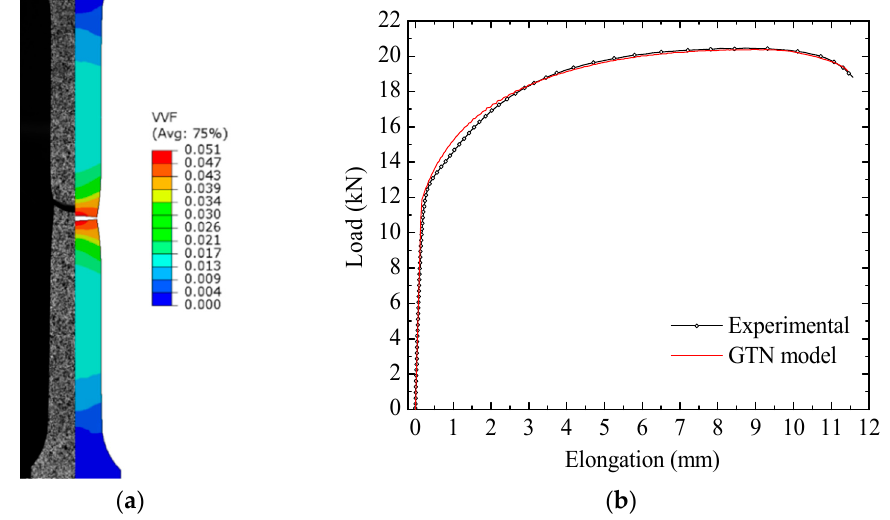
Figure 18. ( a ) Finite element simulation of the uniaxial tensile test: experimental digital image and